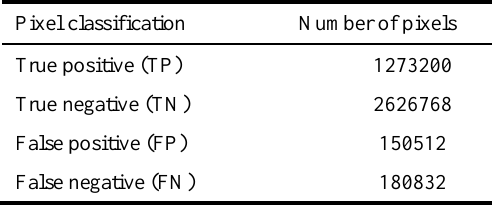
Table 1 Pixel classification